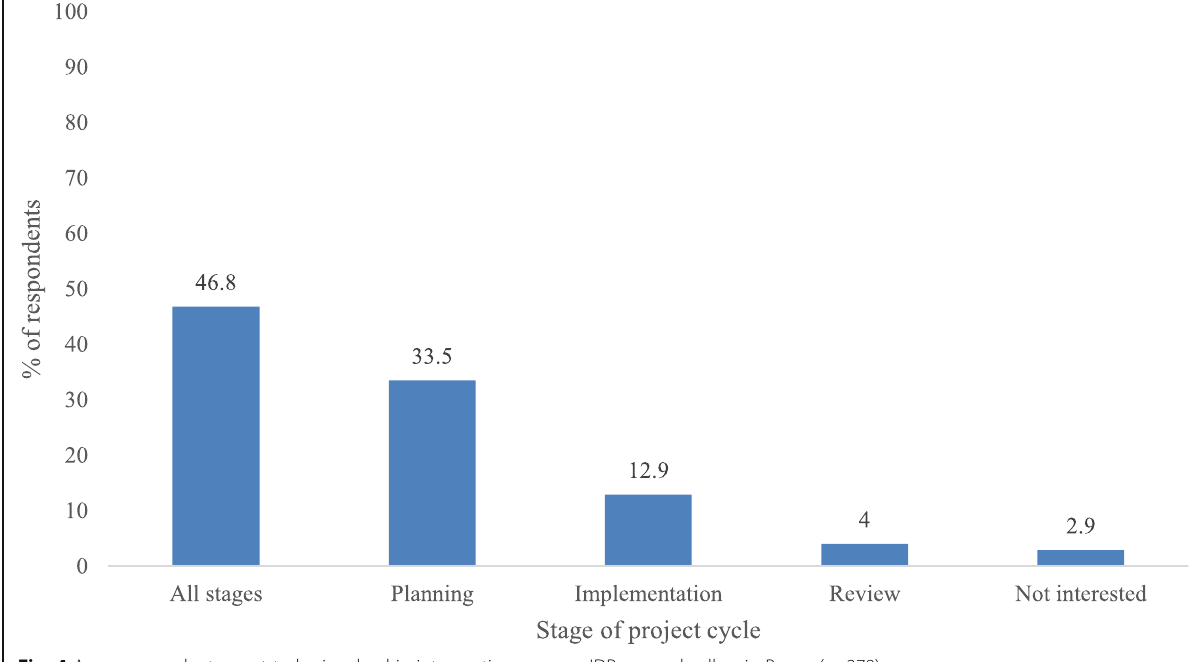
Fig. 4 Areas respondents want to be involved in interventions among IDP camp dwellers in Borno ( n